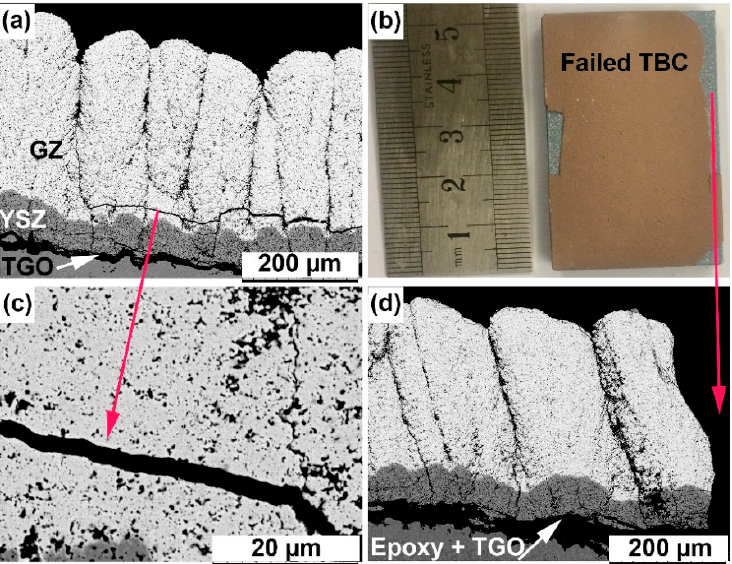
Figure 6. Cross-sectional SEM micrographs showing distinct columnar ytrria stabilized zirconia (YSZ) thermal barrier coating (TBC) microstructures deposited by SPS process [25].